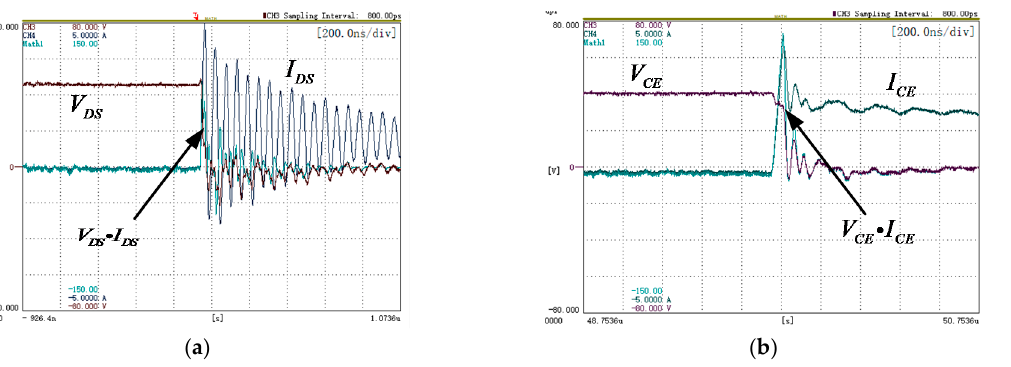
Figure 9. Turn-on loss test waveform. ( a ) GaN, ( b ) IGBT.